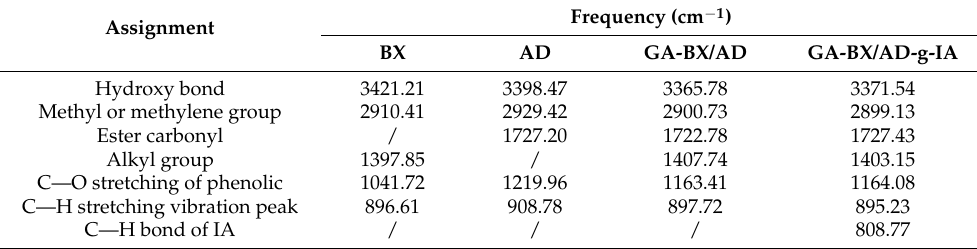
Table 1. FT-IR spectra data of BX, AD, GA-BX/AD, and